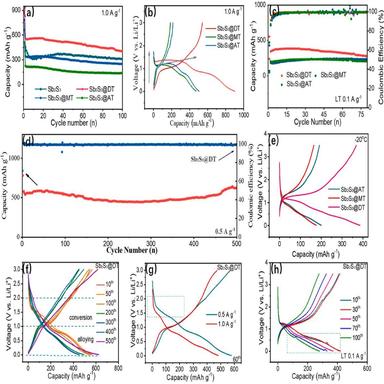
The Cycling performance (a), initial charge/discharge platforms(b) of as-prepared samples at 1.0 A g− 1 . The long cycling properties(d) of Sb2S3@DT at 0.5 A g− 1 . The charge/discharge platforms of Sb2S3@DT during the 0th, 50th, 100th, 200th, 300th, 400th and 500th cycles(f). The charge/discharge platforms at 0.5/1.0 A g− 1 of Sb2S3@DT during the 60th cycle (g). Electrochemical performance of Sb2S3@DT at low temperature (− 20 ◦C): cycling performance (c), initial charge/ discharge platforms(e) of as-prepar